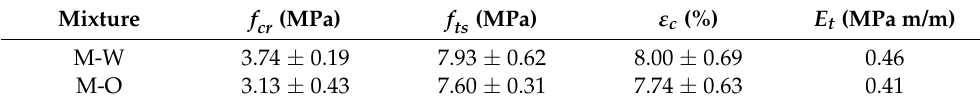
Figure 4. Stress–strain curves of: ( a ) M-W and ( b ) M-O mixtures. Table 5. Tensile properties of SHCC. Table 5. Tensile properties of SHCC.